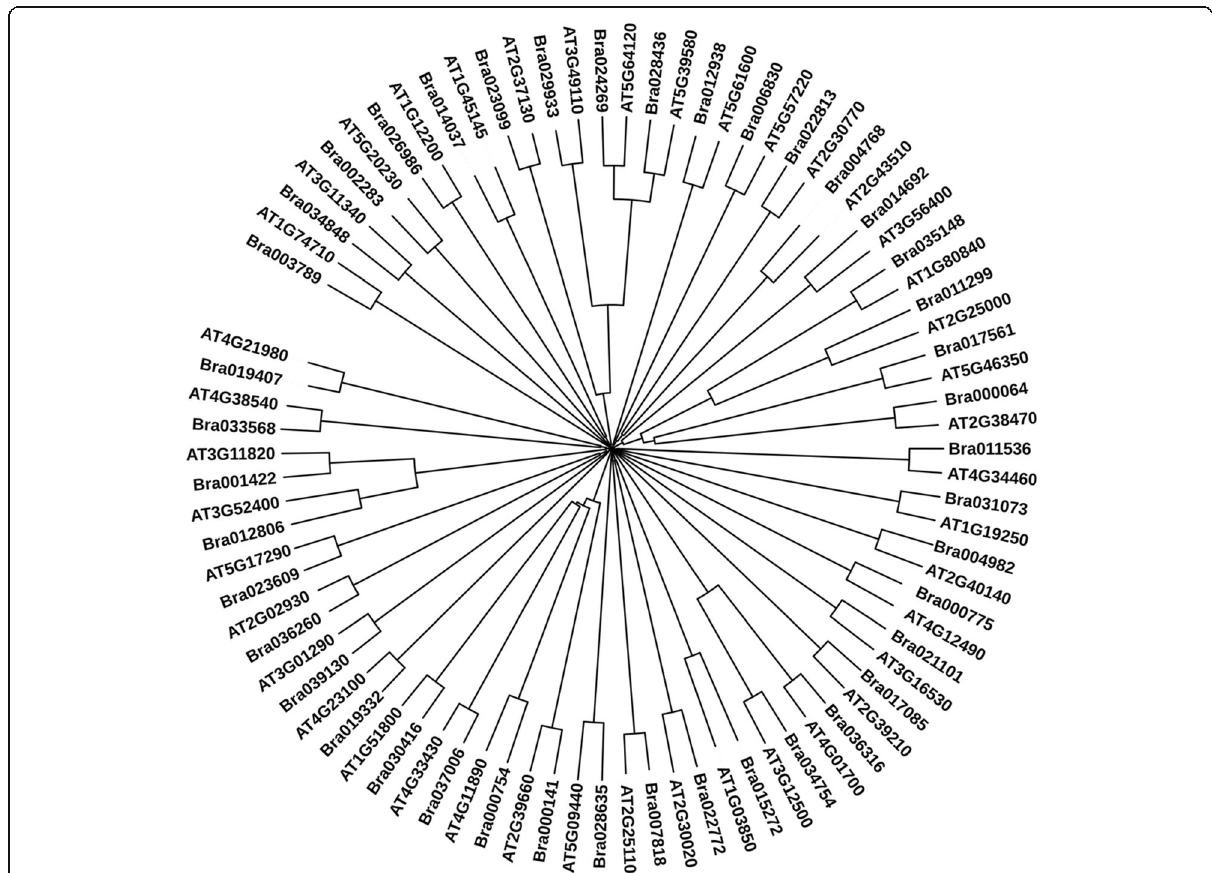
Fig. 4 Neighbor-Joining tree was constructed to determine the relationship among Arabidopsis and Brassica sequences involved in defense response against fungi extracted from contrast JAMC and